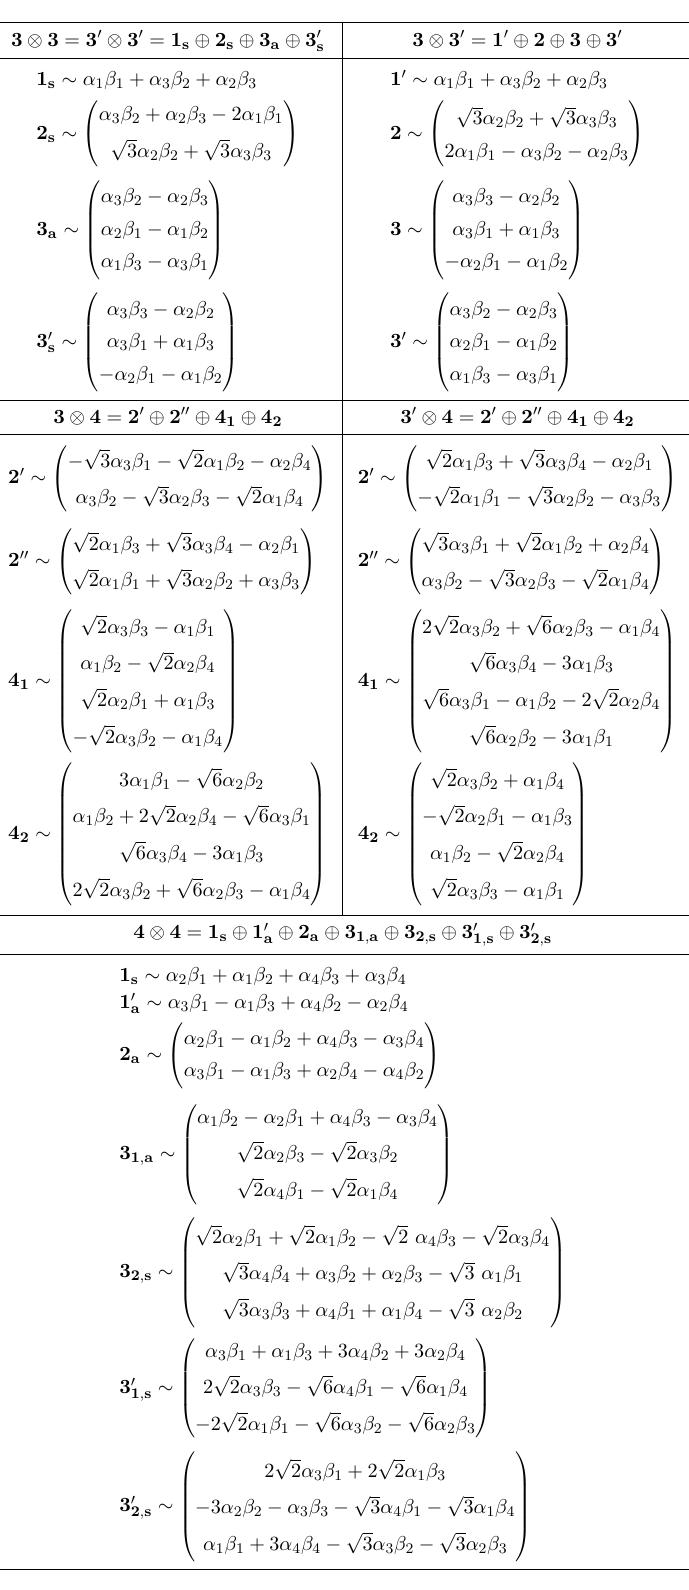
Table 6 . Continuum of table